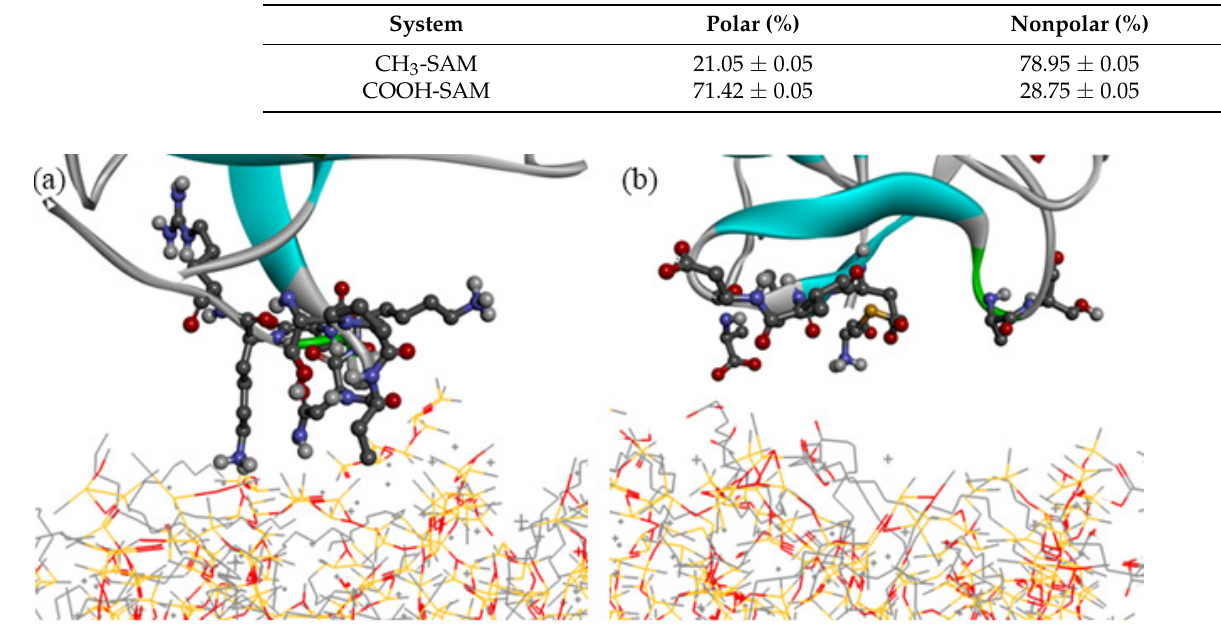
Figure 3. Partial enlarged drawing after stable adsorption. ( a ) CH 3 -SAM surface of self-assembled membrane. ( b ) COOH-SAM membrane surface.